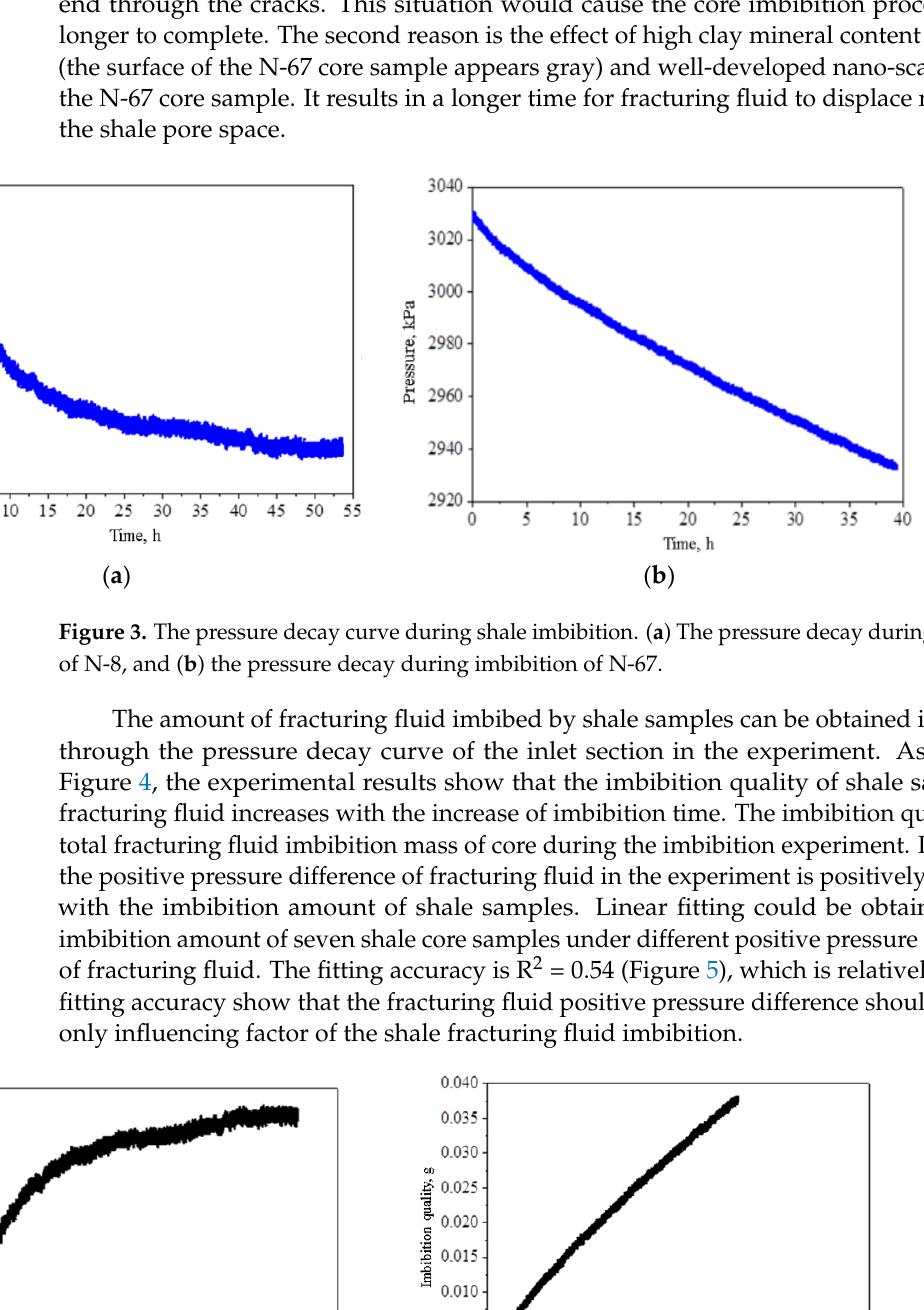
Figure 5. The relationship between positive pressure difference and shale imbibition mass per unit mass. 3.3. Changes in Shale Permeability during Fracturing Fluid Flowback Due to the influence of the heterogeneity of the rock composition of the shale reser- voir, the flowback results of the fracturing fluid imbibed into the core samples show three characteristics. During the flowback experiment, the permeability of core samples N-16, N-25, N-29, and N-38 are significantly lower than their initial gas permeability, as shown in Figure 6a). For the core sample N-52, it created new cracks due to hydration during the imbibition of the fracturing fluid to provide more channels for gas flow. Therefore, after the completion of the first flowback process, the permeability of the N-52 core sample is higher than its initial permeability, resulting in a negative permeability damage rate, as shown in Figure 6b). For core sample N-8, its initial permeability is very low, resulting in a further decrease in permeability after flowback, as shown in Figure 6c). For core sample N-67, its initial permeability is too low to measure its permeability after flowback, so the permeability damage rate of N-67 is 100%.